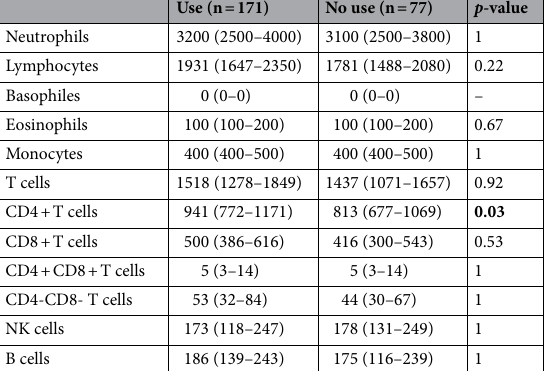
Table 3. Leukocyte proportions among females using or not contraceptive pill with age and BMI in covariates. p -values are highlighted in bold when